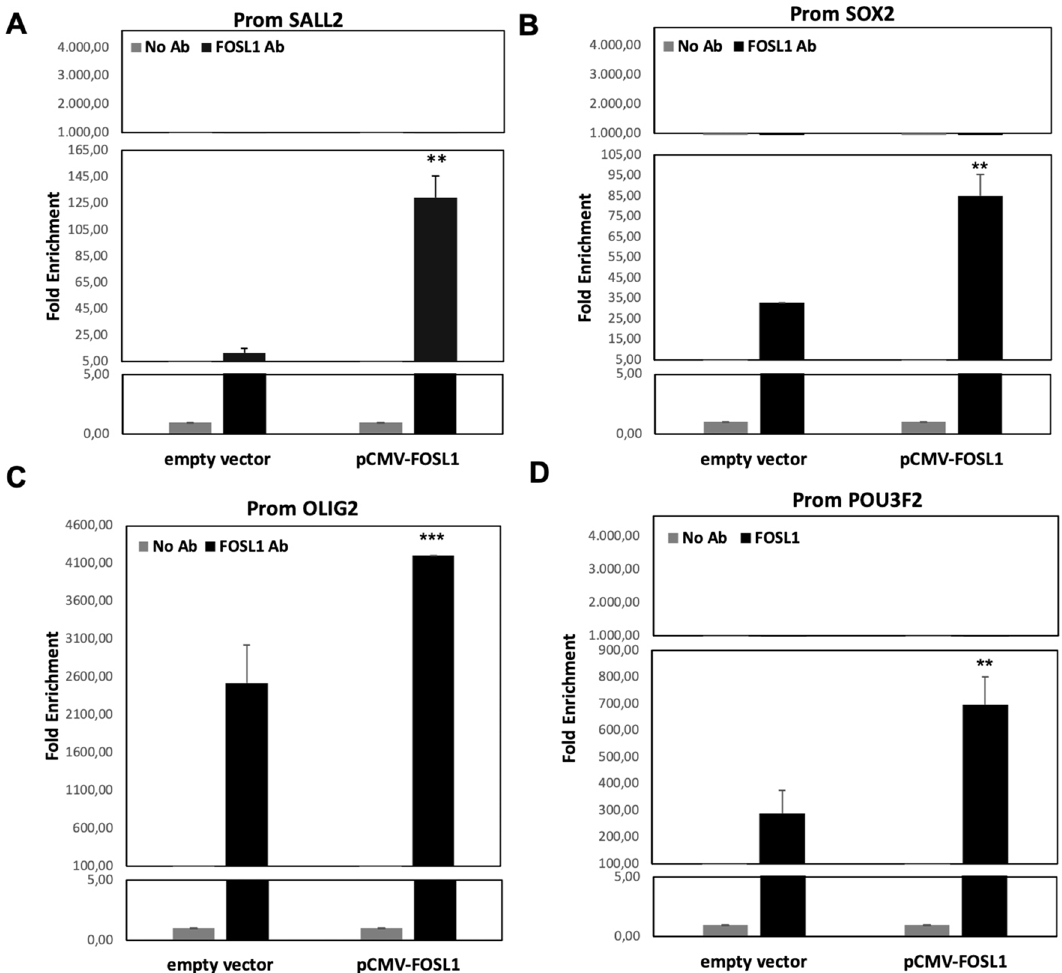
Figure 3. ChIP-Real Time with FOSL1 antibody. Real-time PCR results obtained by ChIp experiment performed on HEK293T cells after 48H from transfection with pCMV-FOSL1 vector. Histograms represent the quantification levels of the promoter regions of ( A ) SALL2, ( B ) SOX2, ( C ) OLIG2, ( D ) POU3F2. The results are normalized for input sample (the chromatin extracted from treated cells) and expressed as fold enrichment of the promoter region of the four TFs found in the FOSL1 Ab samples. p value < 0.05, *; 0.005 **; 0.0005 *** (t-test